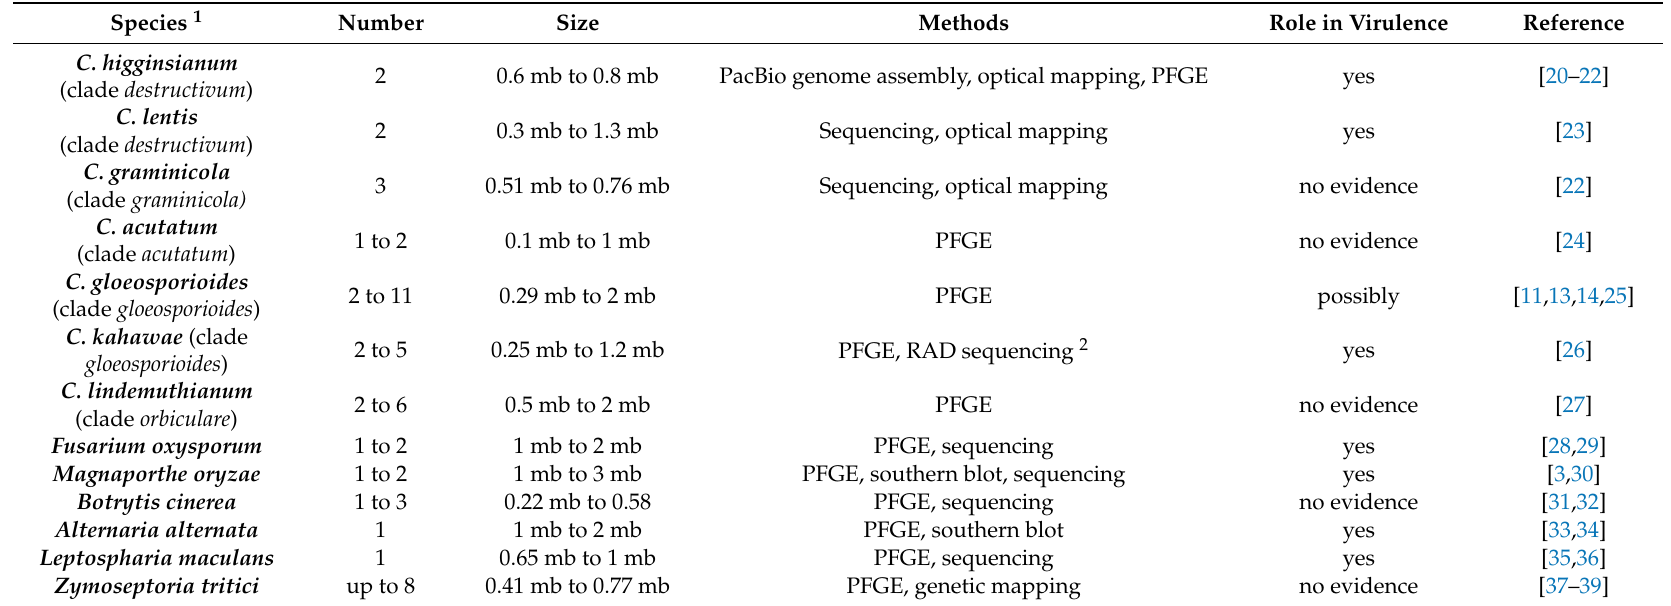
Table 1. Filamentous ascomycetes harboring mini